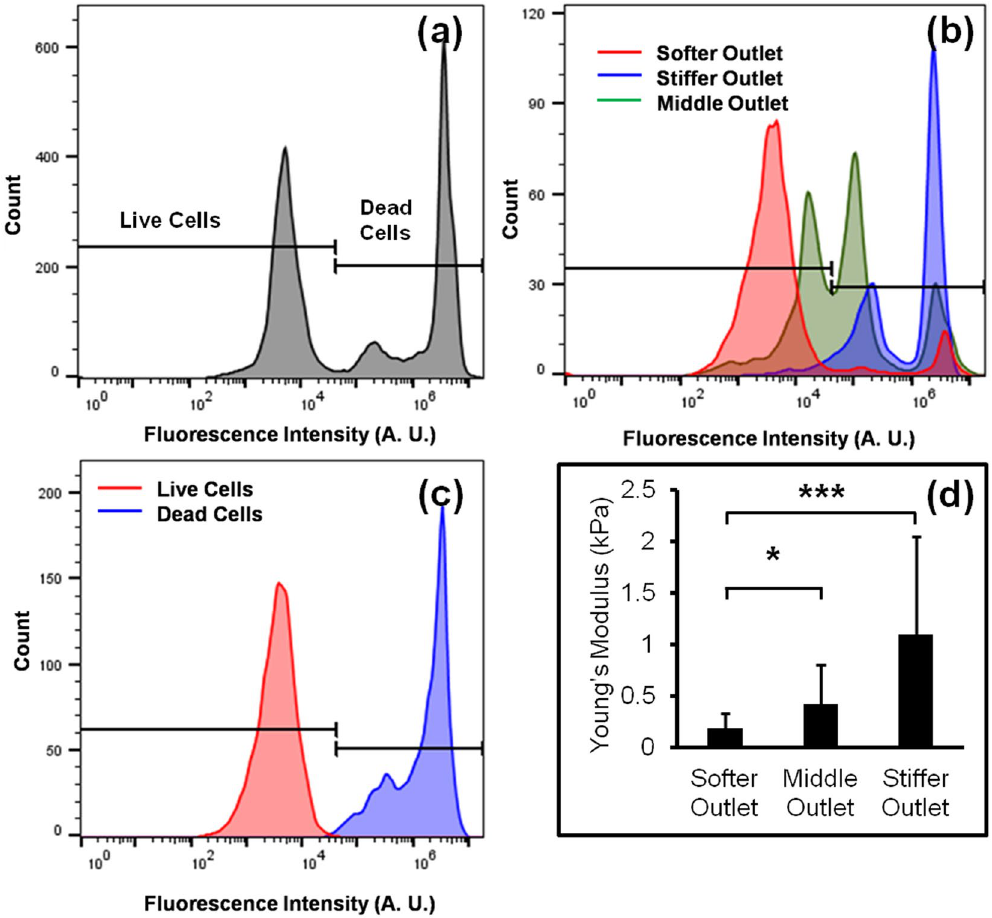
Figure 3. Flow cytometry analysis of the EthD-1 stained cells ( a ) cells in inlet; ( b ) cells collected from three different outlets of the device. The number of live and dead cells was calculated by comparing the results with control experiments; ( c ) flow cytometry data of control live and dead cells stained with Ethd-1 which is used to determine the threshold level to distinguish live and dead cells; ( d ) average Young’s modulus of sorted cells collected from three outlets ( N = 20, * p -value < 0.01, and *** p -value <